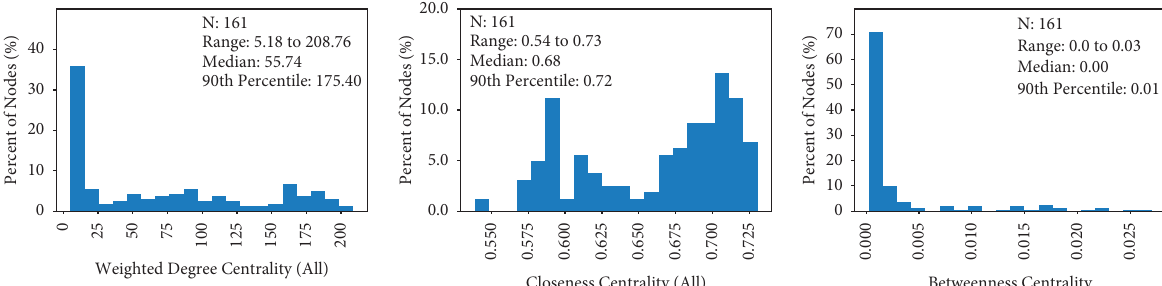
Figure 2: Skill centrality